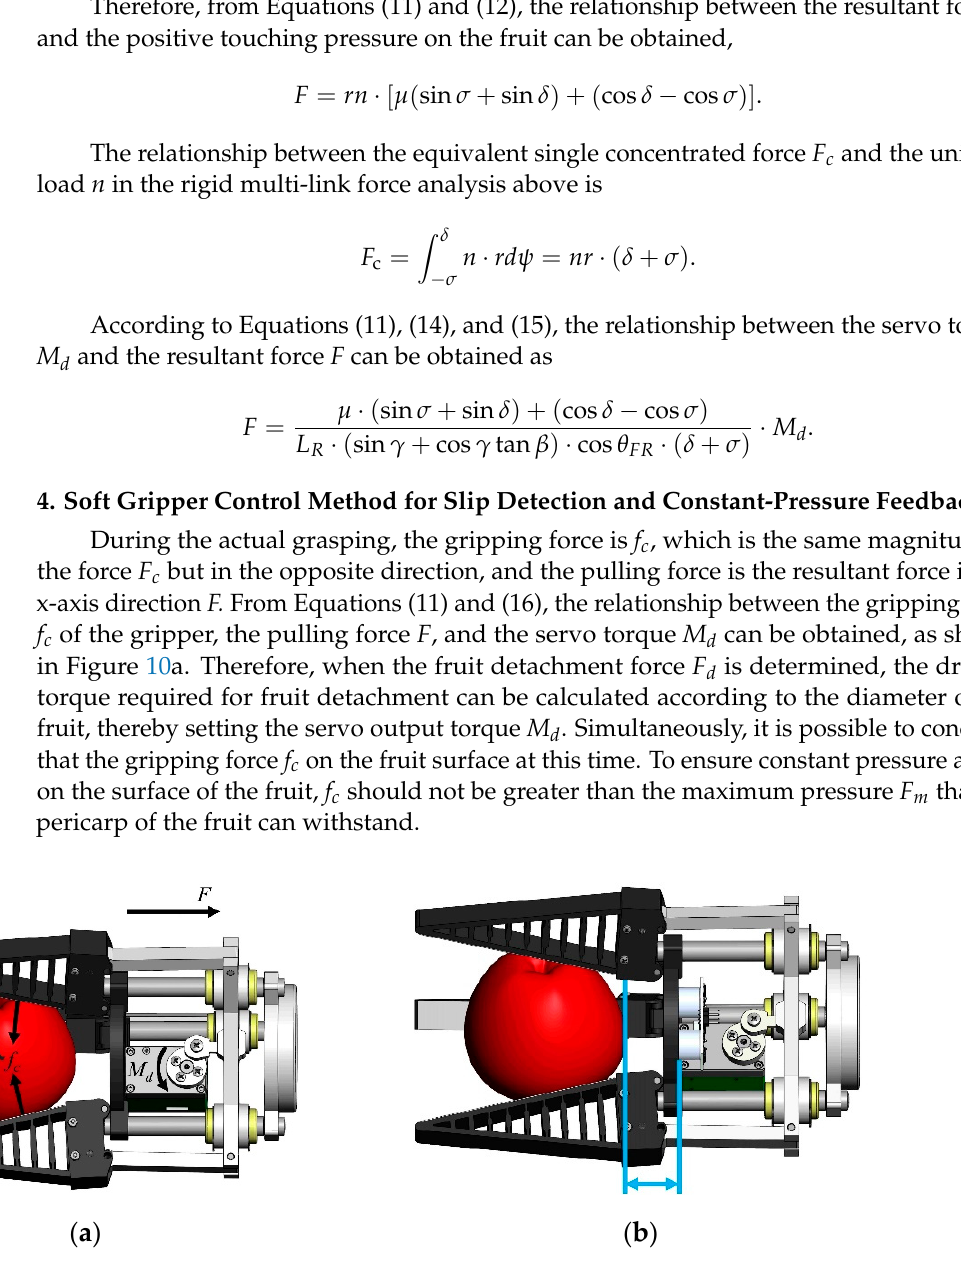
Figure 10. Model of the soft gripper control method: ( a ) the relationship among f c , F , and M d ; ( b ) Relative position detection between fthe ruit and the